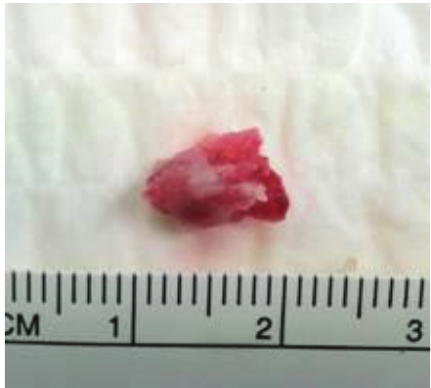
Figure 2: Mass surgically excised from left coronary cusp of aortic valve,approximately9 × 5